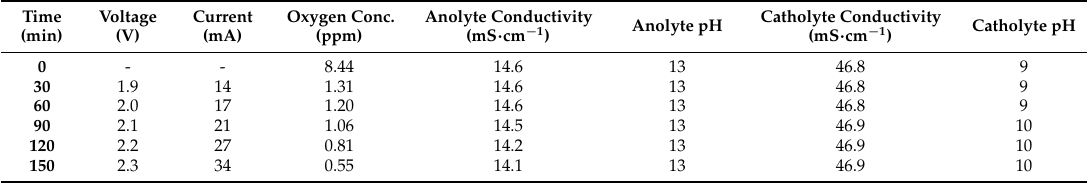
Table 2. Effect of voltage on oxygen removal, pH, and conductivity in 0.1 M NaOH anolyte. Time Voltage Current Oxygen Conc. Anolyte Conductivity (min) (V) (mA) (ppm) (mS · cm − 1 ) Anolyte